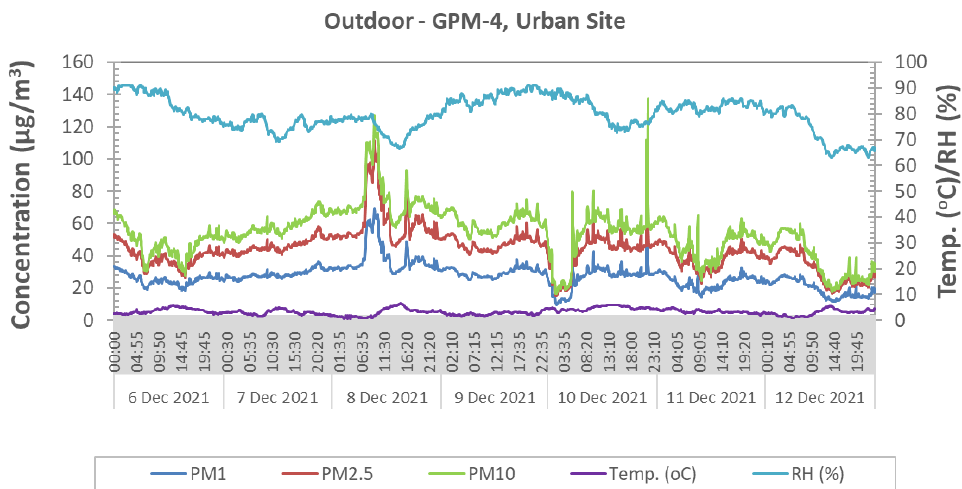
Figure 14. Temporal PM and microclimatic data series for the GPM sensor at the urban site, recorded between 6 and 12 December 2021 (sampling rate: 1–5 min, n = 2032).